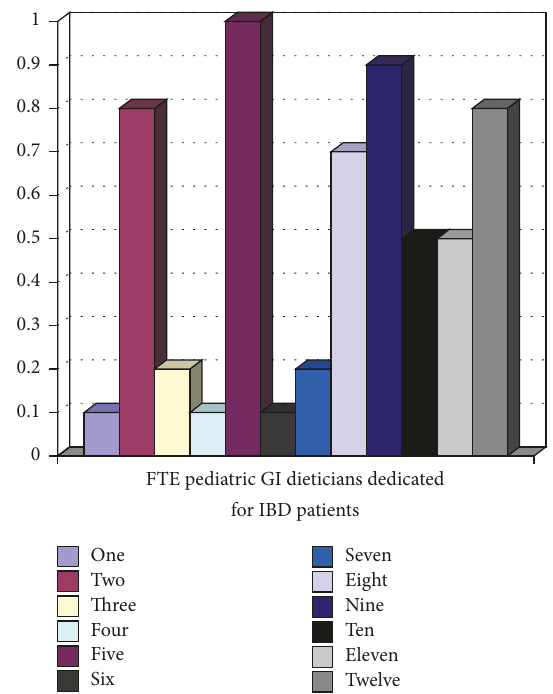
Figure 3: Full-time equivalent (FTE) dietitians for children with IBD per